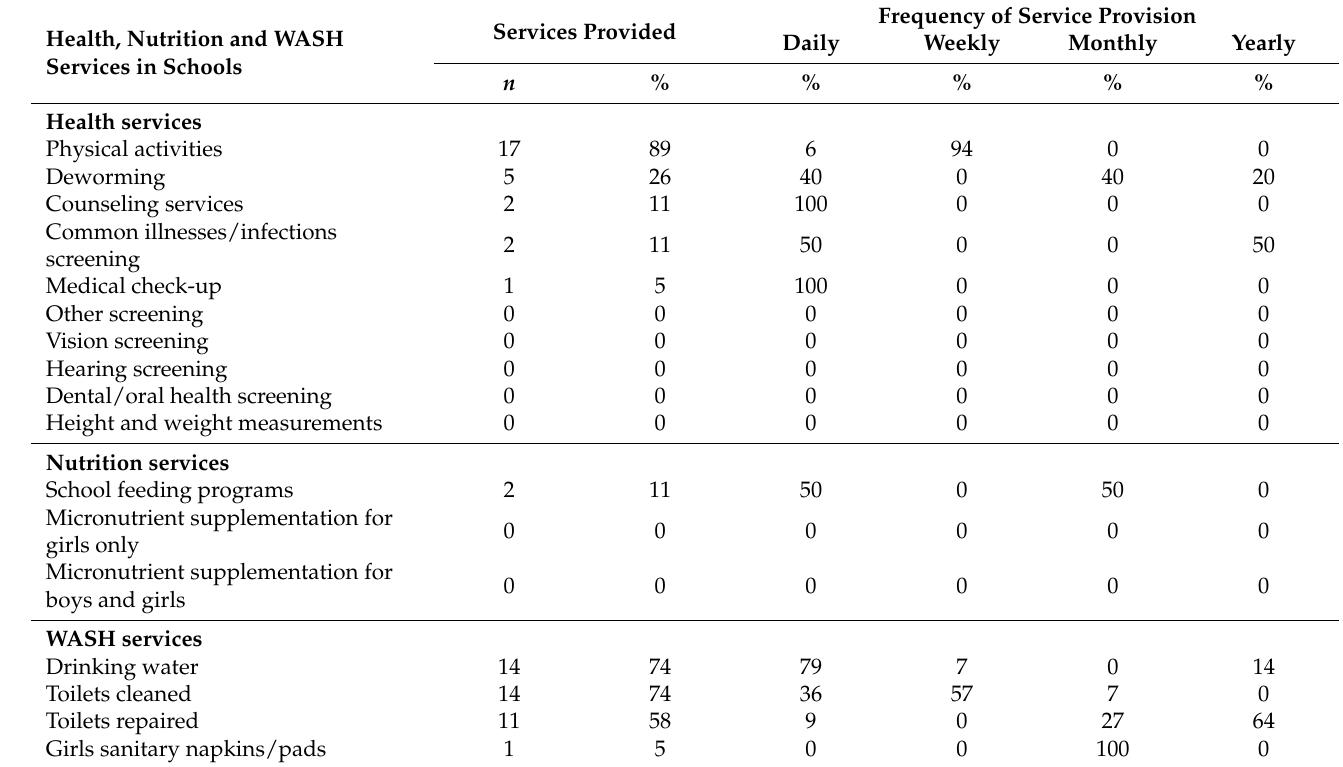
Table 3. Provision of health, nutrition and WASH services and their frequency of provision during the same or previous year of the survey as reported by 19 school administrators in junior secondary schools in